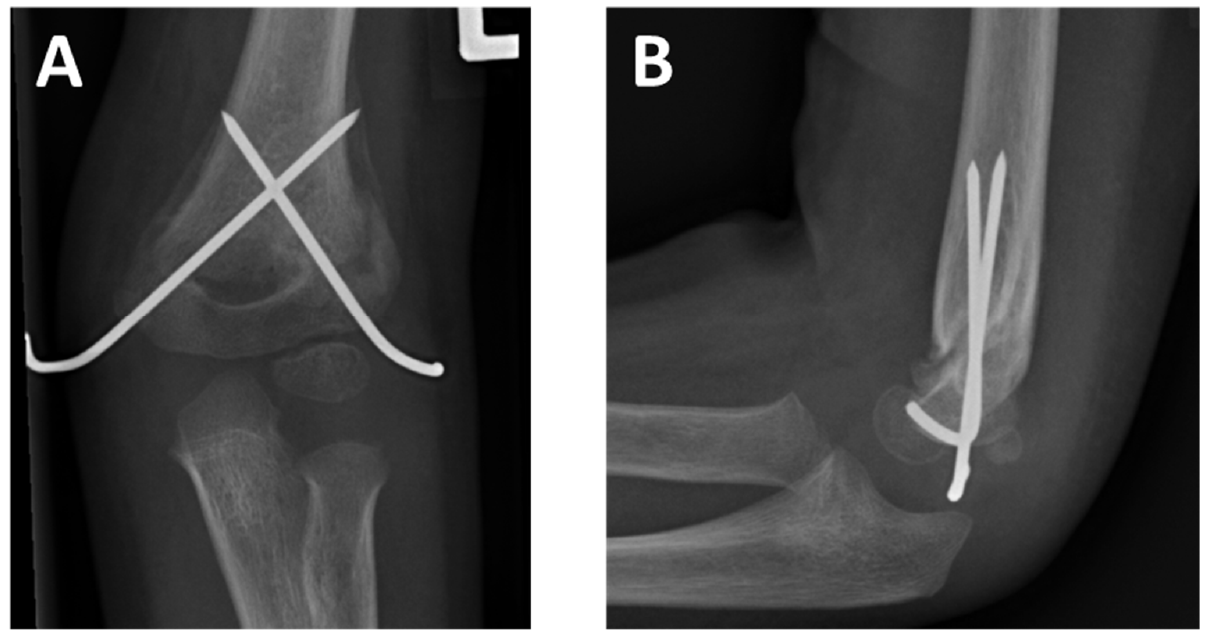
Figure 1. Radiograph of a supracondylar humeral fracture treated by percutaneous crossed pinning in anterior-posterior ( A ) and lateral view ( B ).